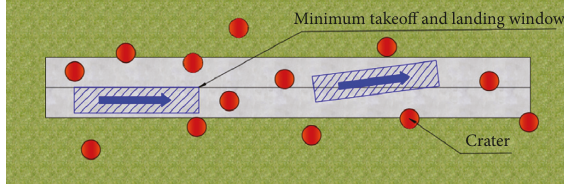
Figure 2: Two ways of takeoff and landing.